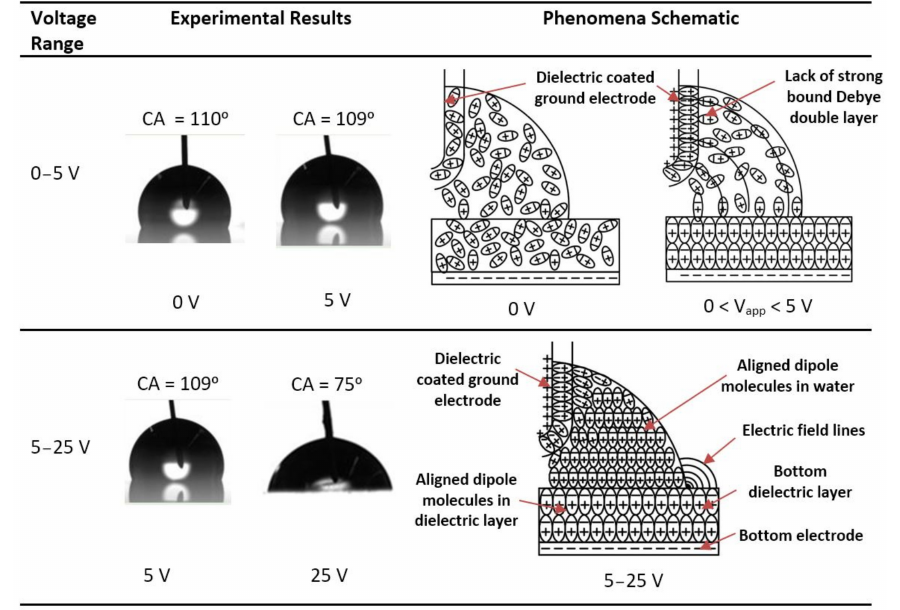
Figure 15. Experimental results and schematic describing the physics of sessile-drop electrowetting with the dielectric-coated ground electrode and increasing DC